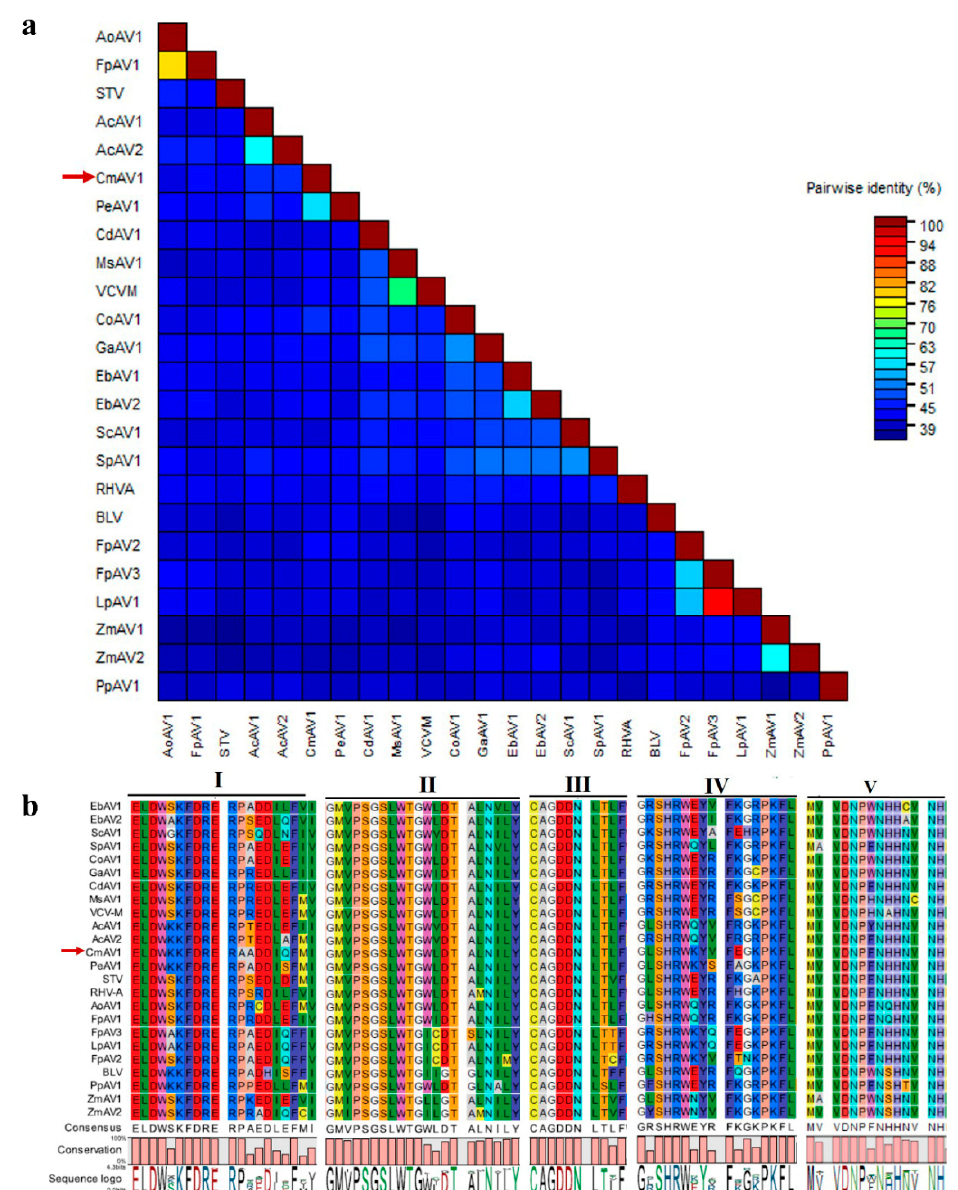
Figure 8. The sequence similarities of RdRps in the family Amalgaviridae . ( a ) The pairwise identities plot of RdRps in the family of Amalgaviridae aligned by MAFFT and displayed by SDT software. ( b ) Amino acid alignment between conserved RdRp motifs of CmAV1 and the selected amalgaviruses.